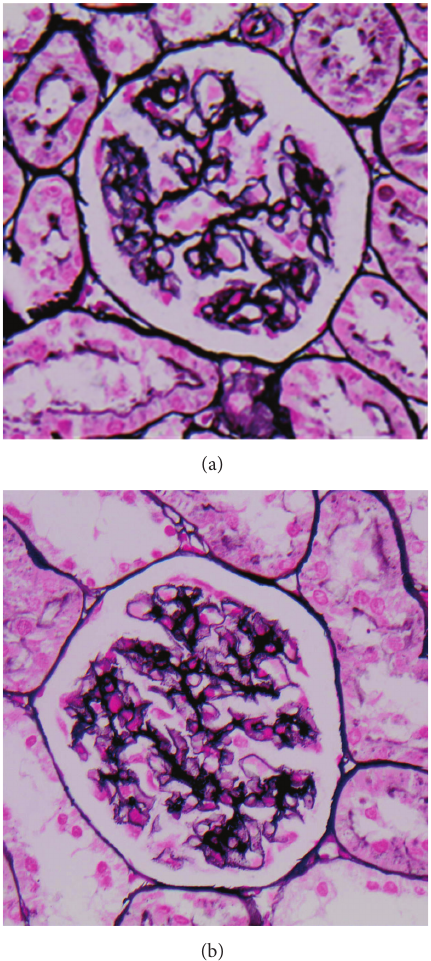
Figure 2: Photon microscopy. (a) Passive Heymann Nephritis. Moderate to severe irregular thickening of glomerular capillary basement membranes (Silver Methenamine, × 400). (b) Passive Hey- mann Nephritis after rapamycin administration. Mild to moderate thickening of glomerular capillary basement membranes (Silver Methenamine, ×